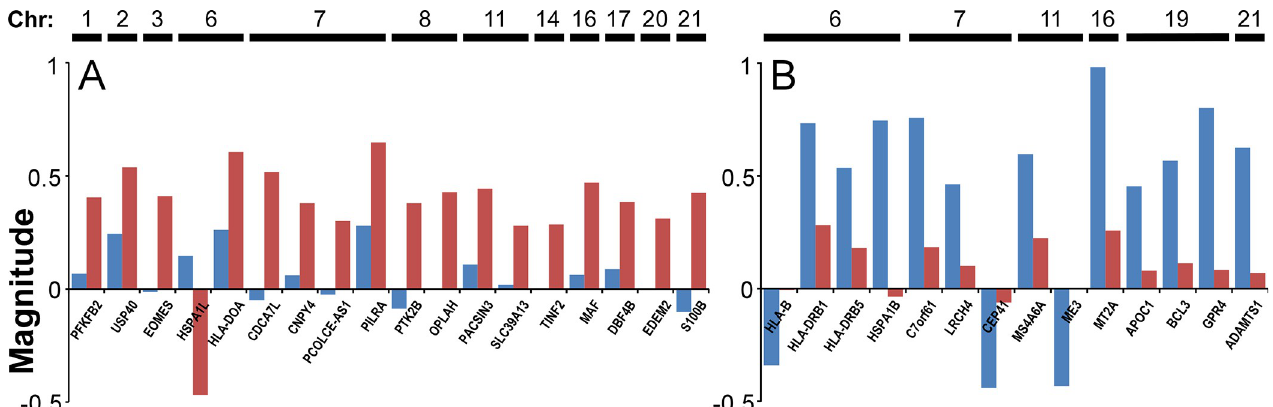
Fig 10. Differential expression of LOAD risk factor genes in Gene Sets 1 and 2. The magnitude of log FC and log RoR calculated by Eq (1) (PFC region, blue) and (3) (RoR, red) were plotted for risk factor loci-associated genes identified in ( A ) Set 1 (Table H in S1 Data) and ( B ) Set 2 (Table I in S1 Data), where chr signifies chromosomal assignment. RoR reveals polarity of candidate risk gene expression changes with respect to tauopathy vulnerability.